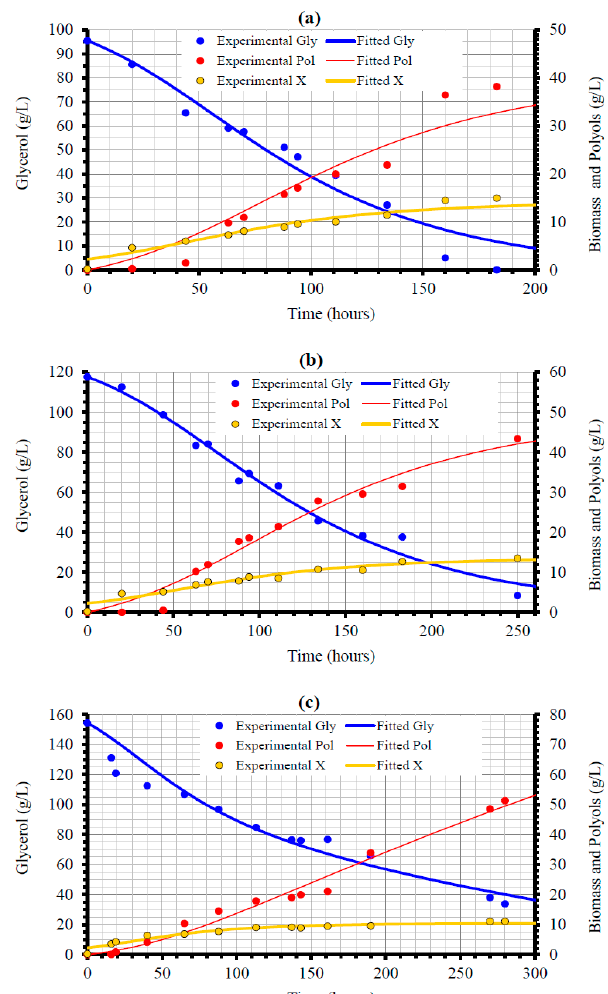
Figure 5. Experimental data and fitted values showing the evolution of biomass ( X ), glycerol ( Gly ) and total polyols ( Pol ) concentration during growth of Yarrowia lipolytica on glycerol at: ≈ 100 g/L ( a ); ≈ 120 g/L ( b ); ≈ 150 g/L ( c ), initial substrate concentrations in shake-flask experiments under nitrogen-limited conditions. Culture conditions as in Table 3. Each experimental point is the mean value of two independent determinations (SE ≤ 18%).